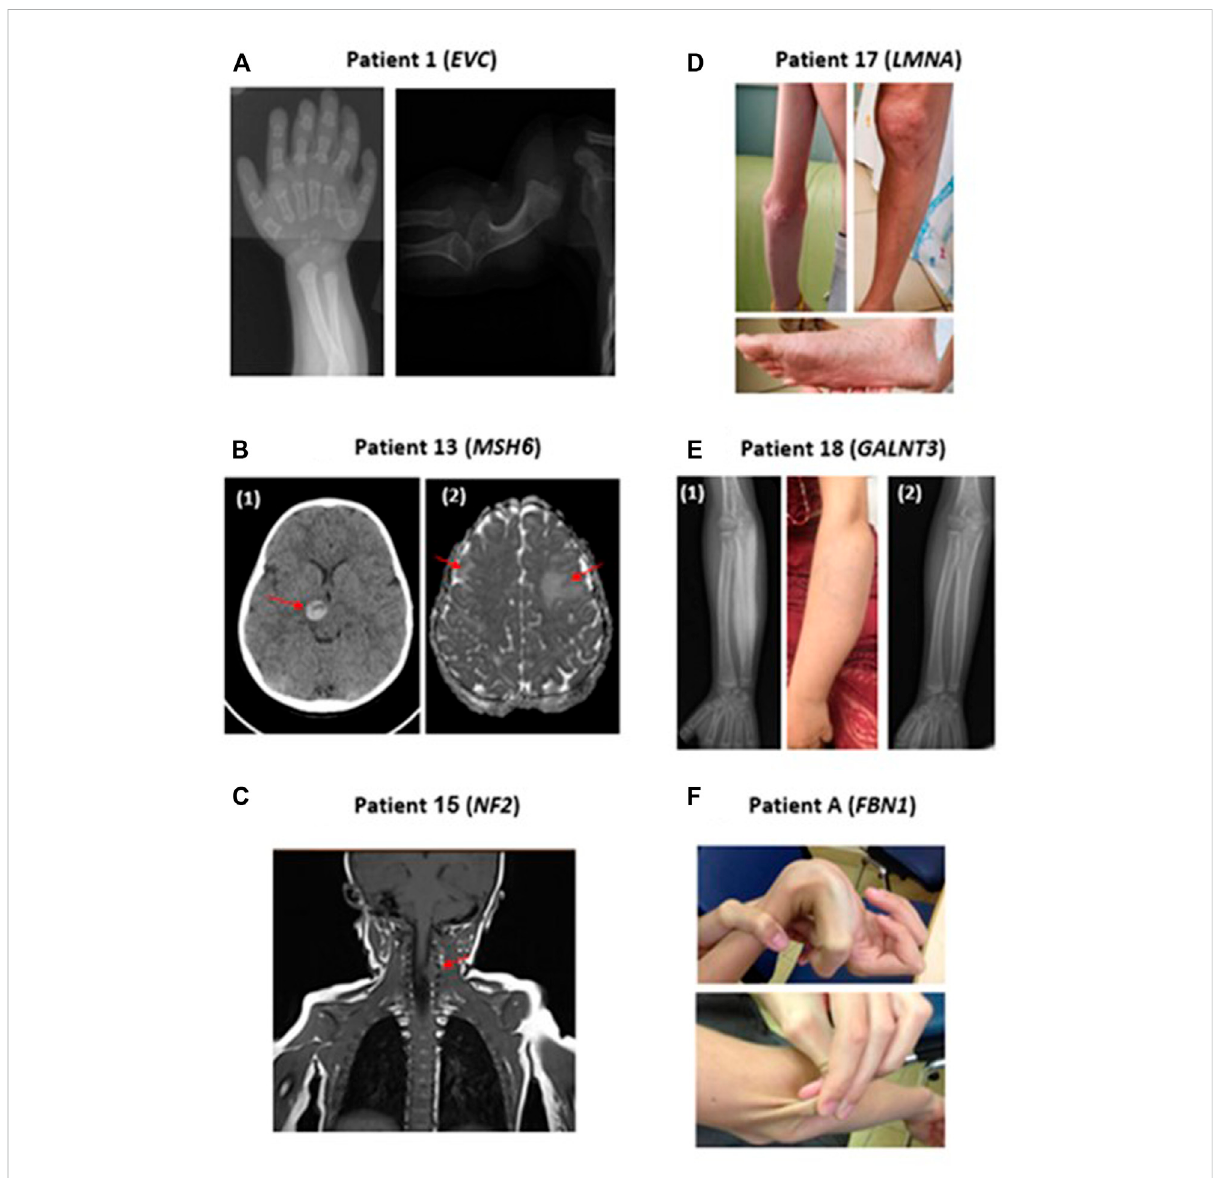
FIGURE 1 Representativeclinical fi ndingsinpatientswithpositivemoleculardiagnosisinourcohort. (A) Patient1 :Radiographsdemonstratingpolydactyly and deformation of the humerus, in a patient with Ellis-Van Creveld syndrome ( EVC mutation). (B) Patient 13 : Brain CT (1) and MRI (2) scans demonstrating hemorrhage of the thalamus and bilateral frontal lesions in a patient with compound heterozygous MSH6 mutations. (C) Patient 15 : MRIscanpreformedduetoorbitallesiondetectedanincidental fi ndingofaspinallesionatC4-5levelinapatientwith NF2 mutation. (D) Patient 17 :Patientwith LMNA mutationpresentingwithwidespreadtelangiectasiasandScleroderma-likeskinchanges. (E) Patient18 :(1):Hyperostosisofthe right ulna secondary to GALNT3 mutation demonstrated in radiographs and clearly visible in the adjacent photograph (2) Radiographs of the right Ulna following phosphorus chelator therapy, demonstrating a substantial improvement of hyperostosis. (F) Patient A: Patient with Marfan syndrome presenting with joint hypermobility and hyper elastic